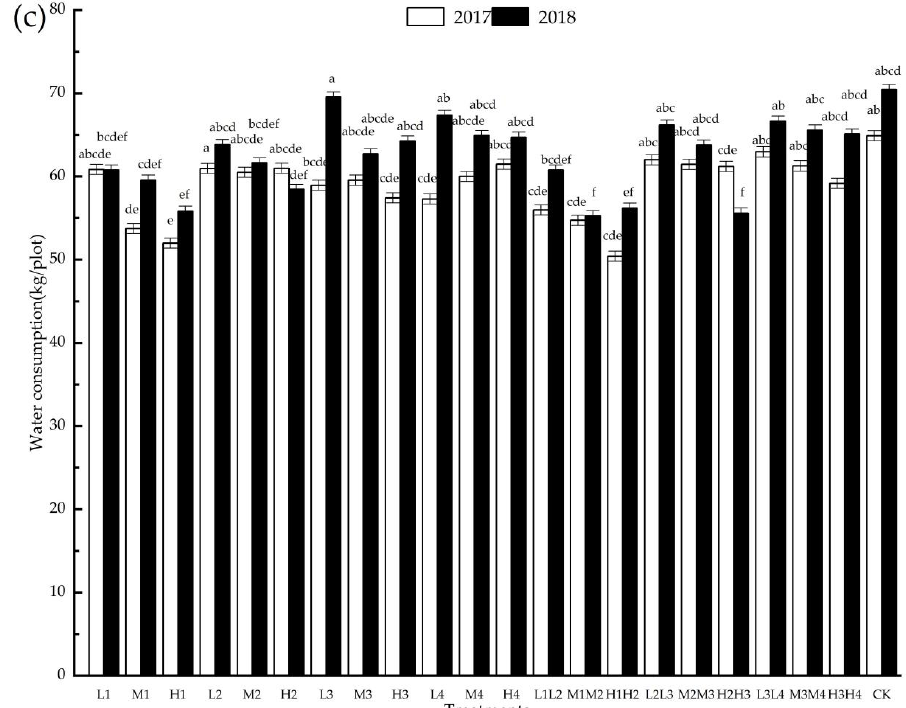
Figure 3. The water consumption during each growth stage ( a ) in 2017, ( b ) in 2018, and ( c ) total water consumption for the whole growth period in 2017 and 2018. Different lowercase letters represent significant levels of each column at p ≤ 0.05 in 2017 or 2018. L: light water deficit, M: medium water deficit, H: severe water deficit. The number “1”, “2”, “3” and “4” represent the tillering, jointing and booting, flowering, and milk ripening stages, respectively.